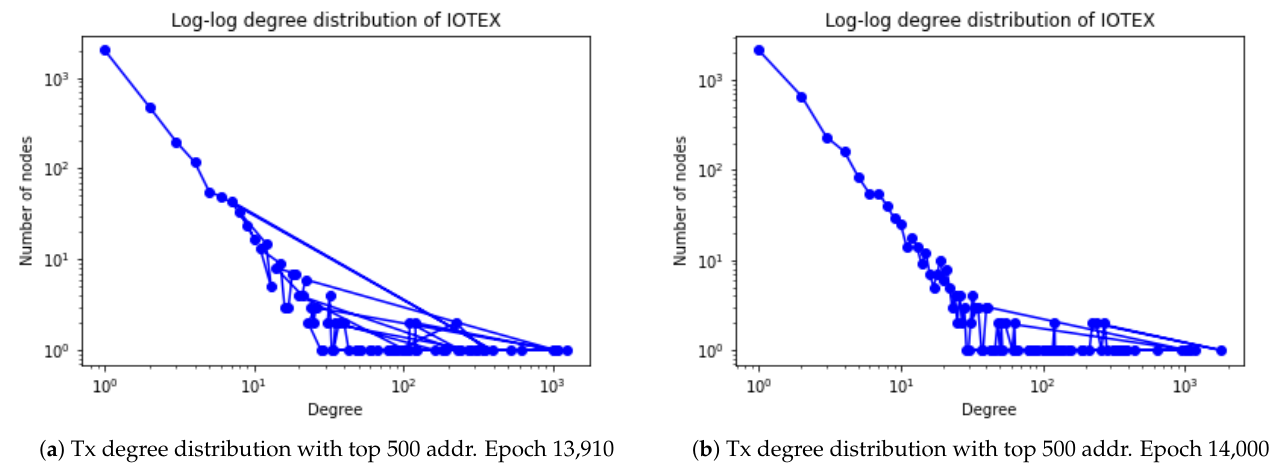
Figure 5. Degree distribution of IoTeX addresses in December 2020.